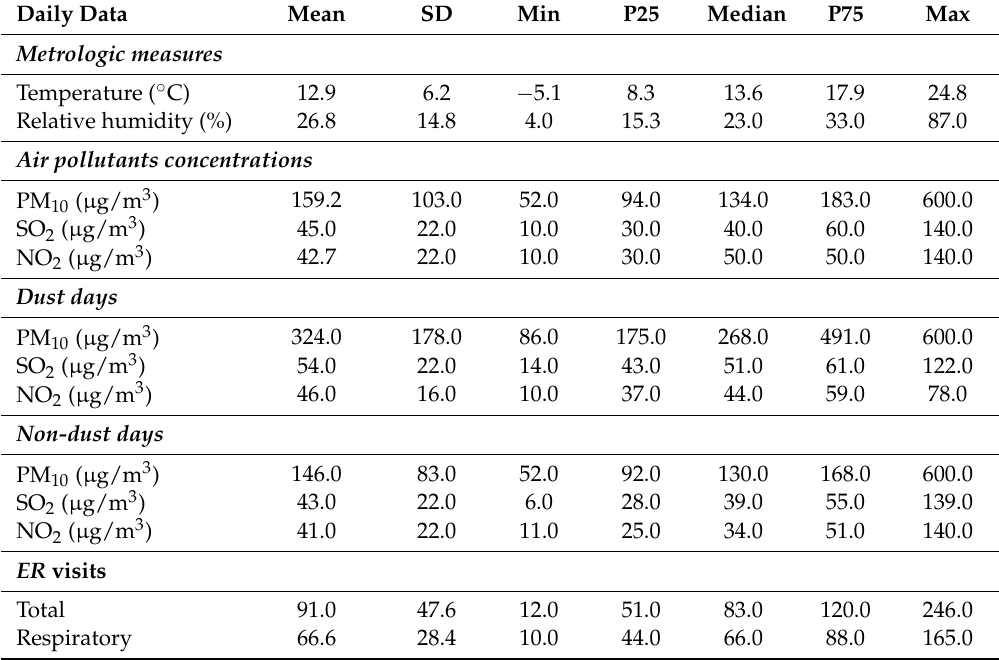
Table 1. Descriptive statistics on meteorological variables, air pollution levels and ER visits in spring time in Lanzhou,